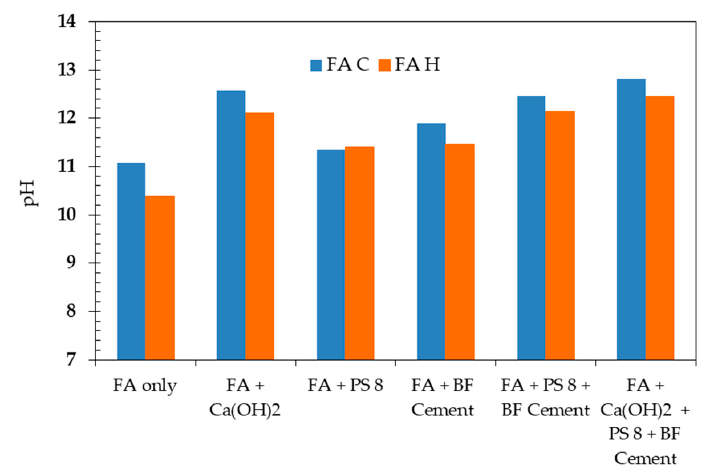
Figure 4. The pH of coal fly ashes and mixtures of coal fly ashes and additives.